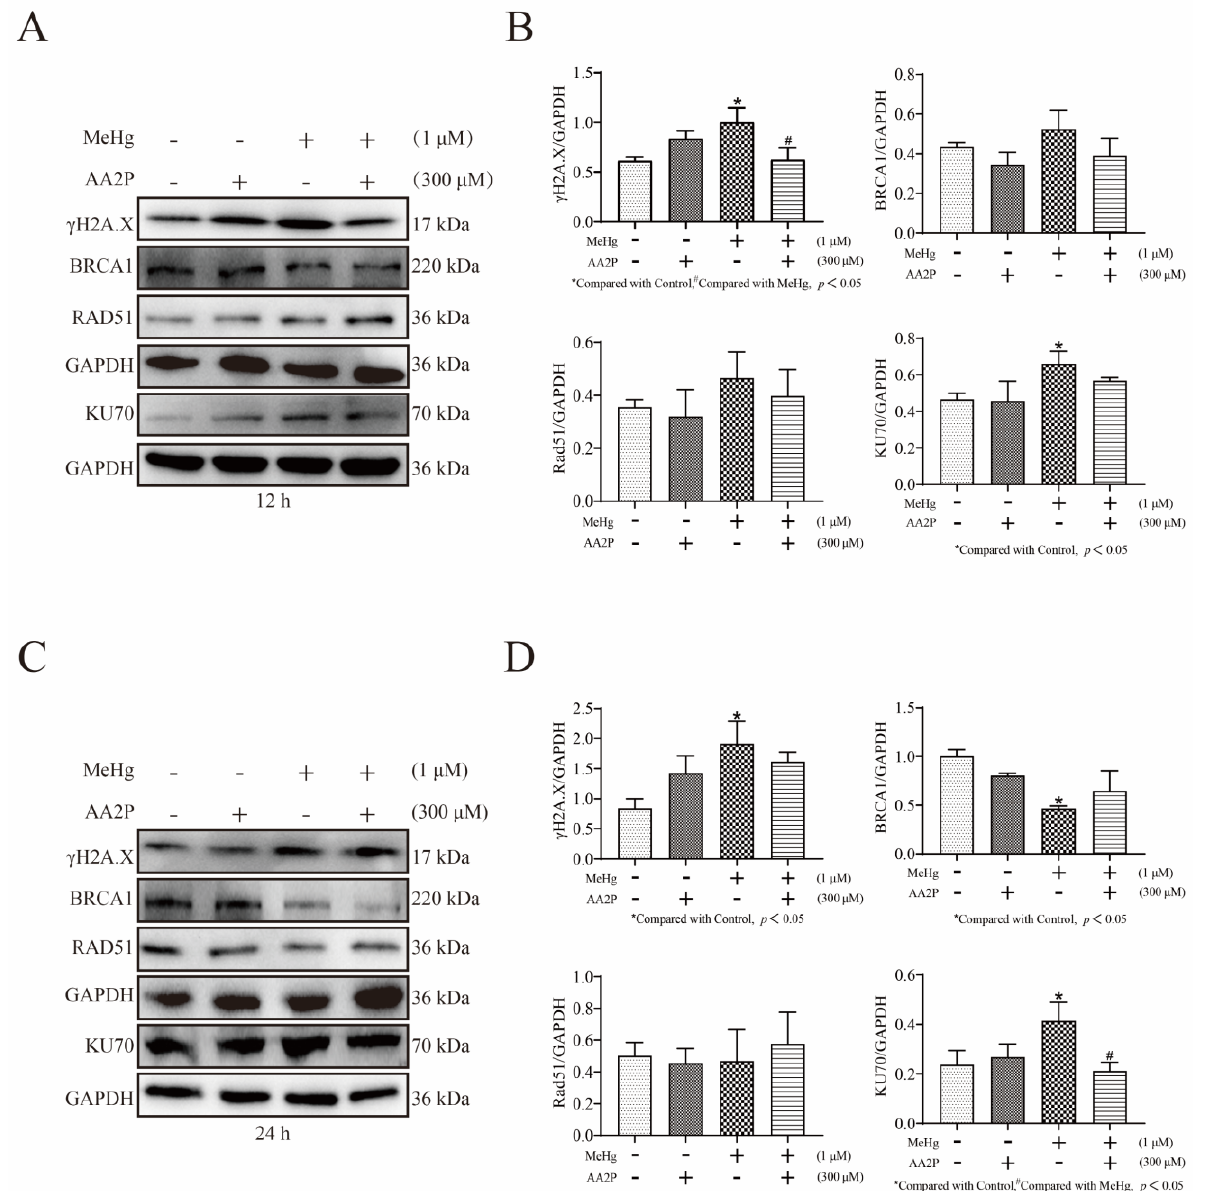
Figure 6. AA2P reduces MeHg-induced DNA damage and NHEJ repair in SH-SY5Y cells. ( A ) Western blot analysis of γH2A.X, BRCA1, RAD51, and KU70 expression in SH -SY5Y cells co-treated with 300 μM AA2P and 1 μM MeHg for 12 h. ( B ) The Tanon-2500 fully automated digital gel image analysis system was used to analyze the net optical density of the Western blot strips. ( C ) Western blot analysis of γH2AX, BRCA1, RAD51, and KU70 expression in SH -SY5Y cells co-treated with 300 μM AA2P and 1 μM MeHg for 24 h. ( D ) The Tanon-2500 fully automated digital gel image analysis system was used to analyze the net optical density of the Western blot strips. All values are represented as means ± SD ( n = 3).